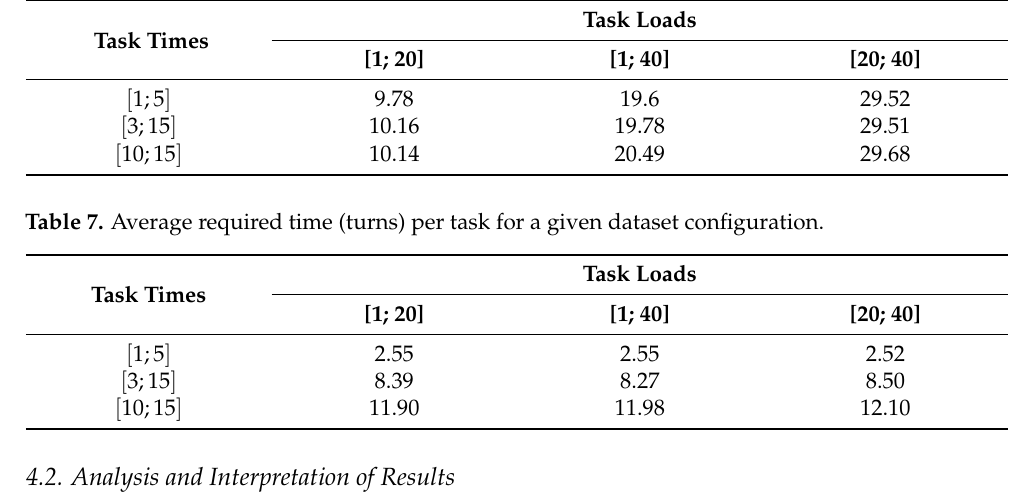
Table 6. Average required processing power per task for a given dataset configuration.